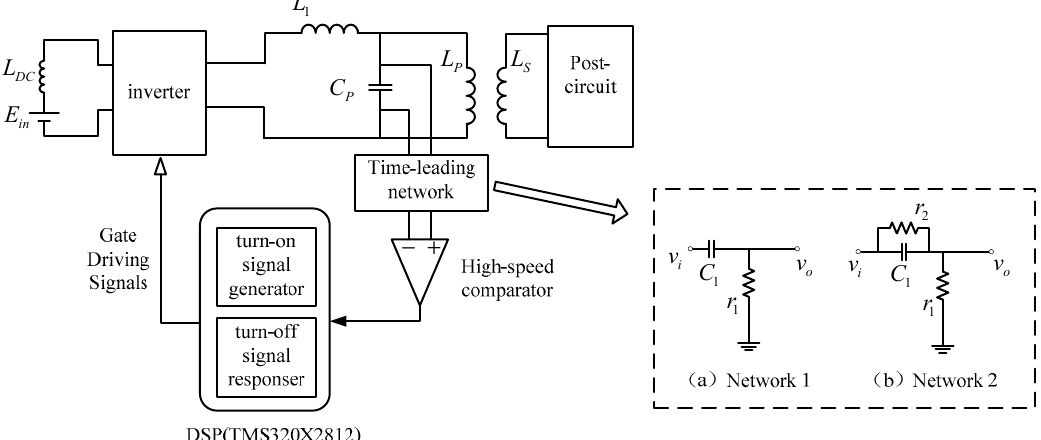
Figure 10. Schematic diagram of overlapping-time self-regulating circuit.